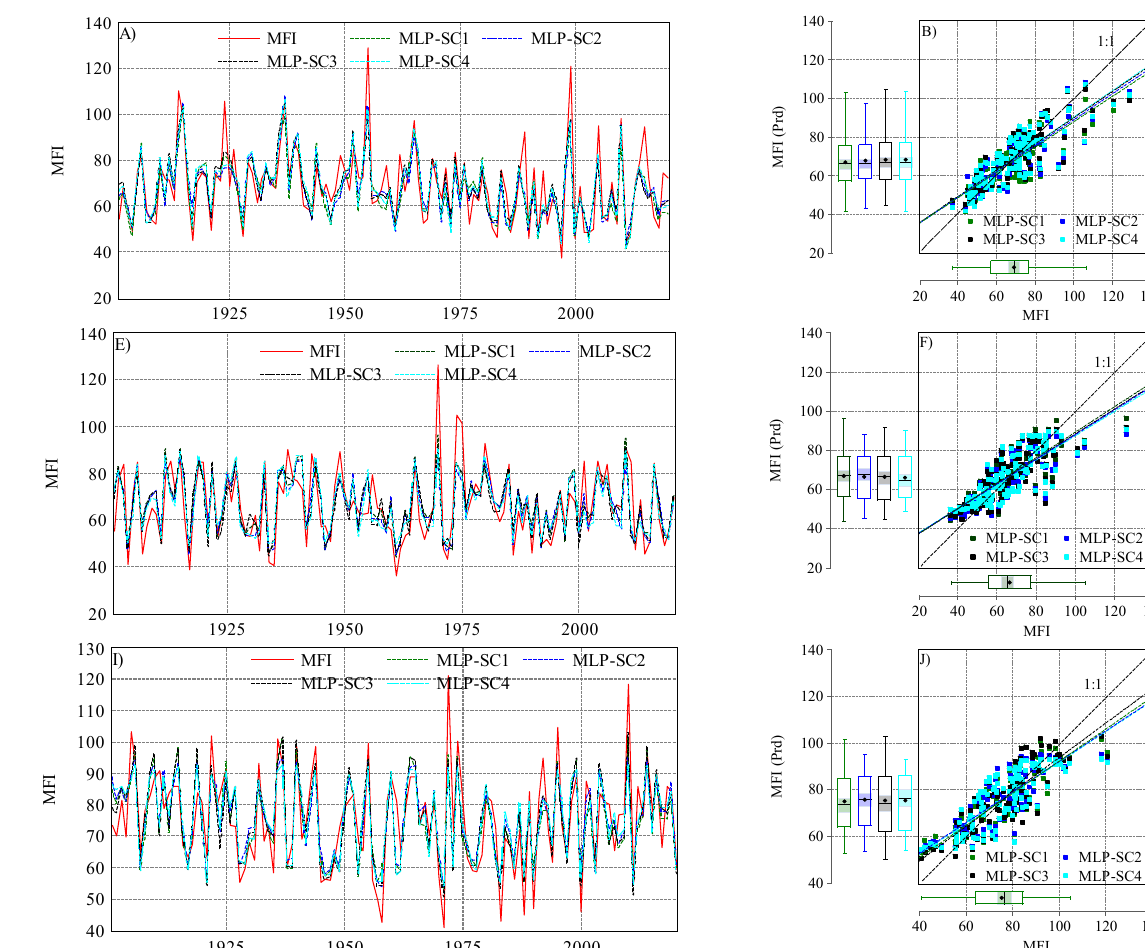
Figure 4. Normal distribution of MFI values for studied stations between 1901 and 2020.